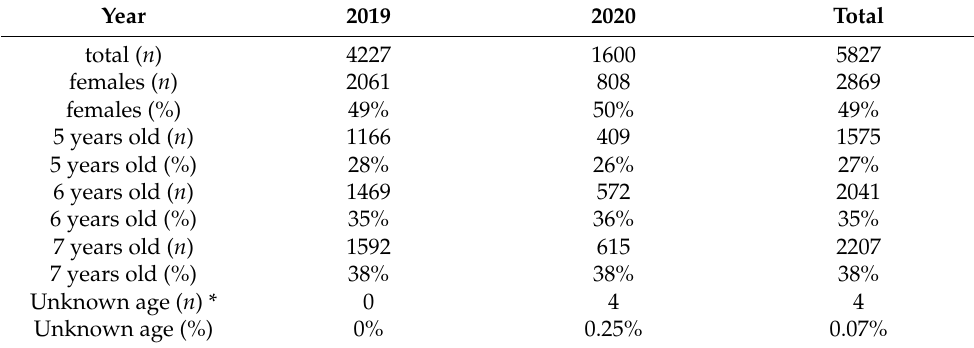
Table 1. Descriptive analysis of the